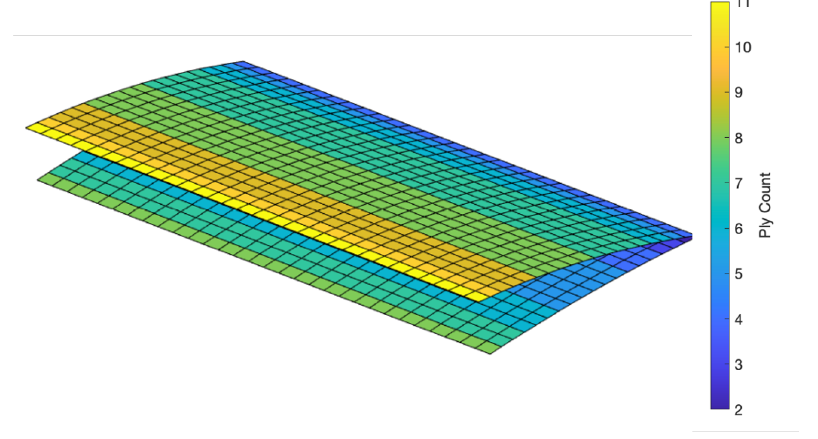
Figure 2. TRIC skin ply drop pattern (one layer has a thickness of 0.12 mm).